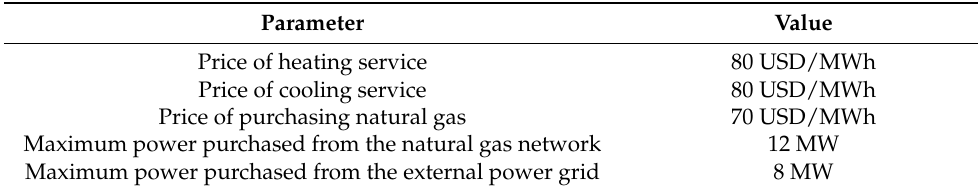
Table 3. Prices of energy services and parameters of the external energy network.